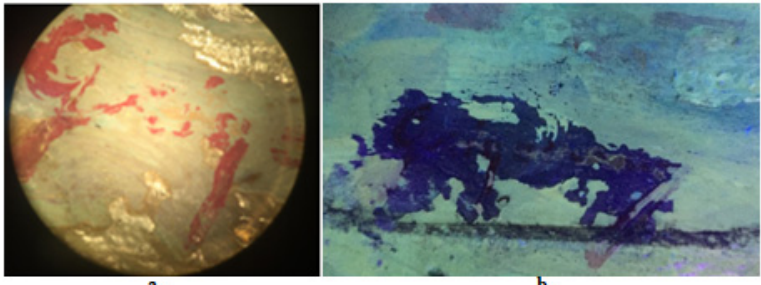
Figure 6. Painter’s signature: ( a ) microphotography of a fragment by binocular stereomicroscope; ( b ) UV reflectography image of the entire area.